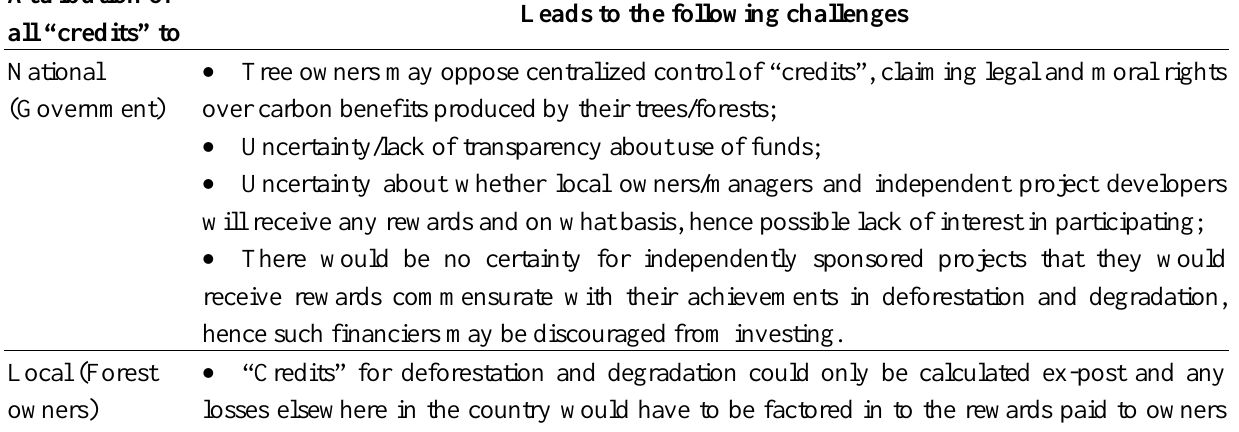
Table 2. Summary of challenges facing the public and the local attribution of REDD+ credits within national REDD+